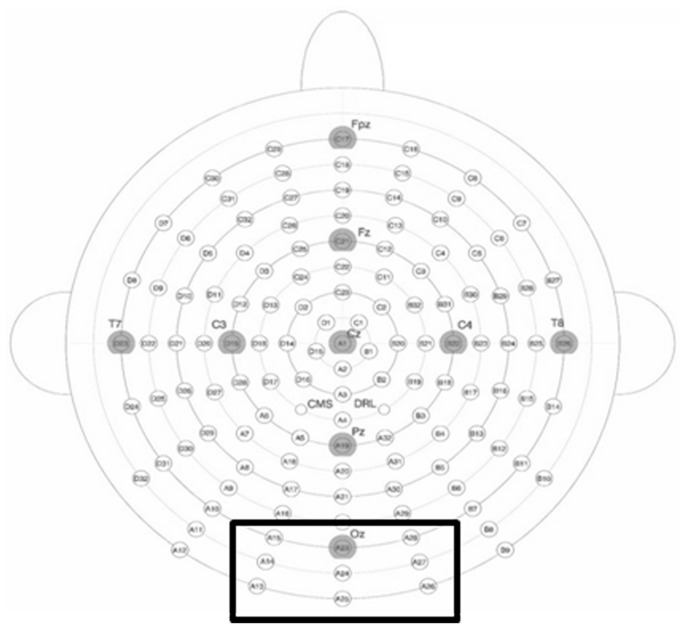
EEG 128 electrode placement (Biosemi).The black square delineates the electrodes of interest.